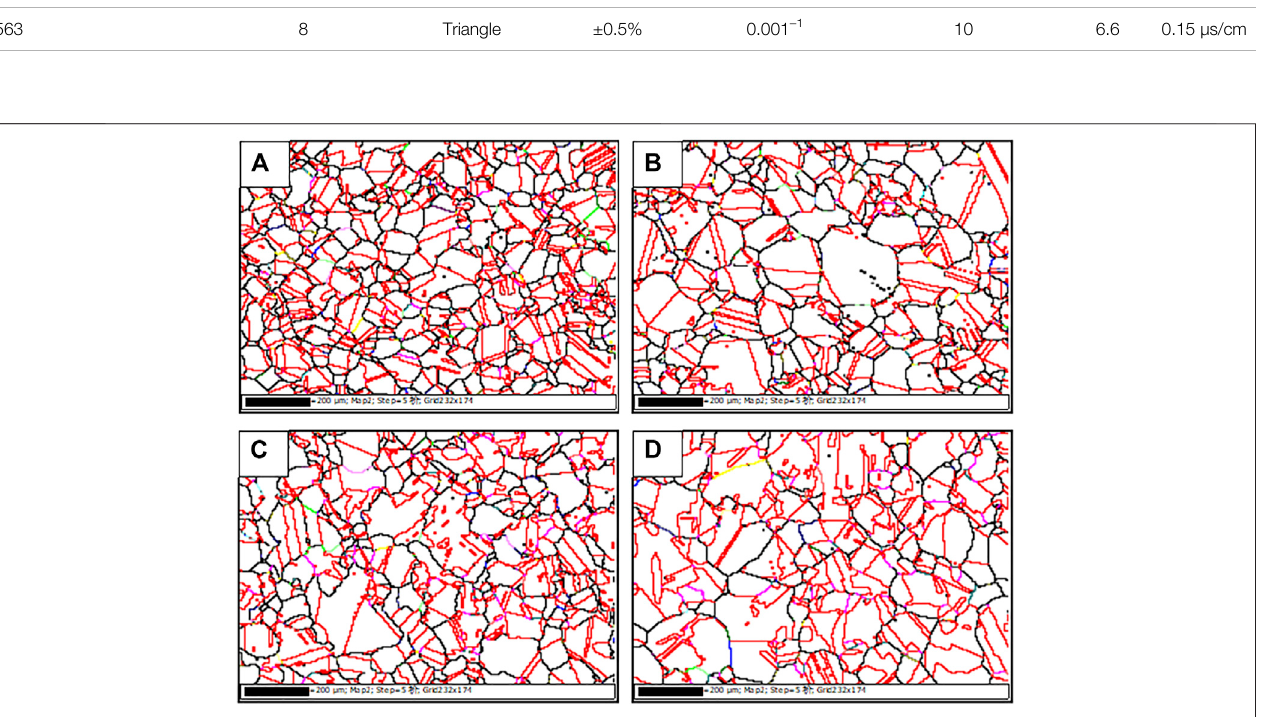
Frontiers in Materials |